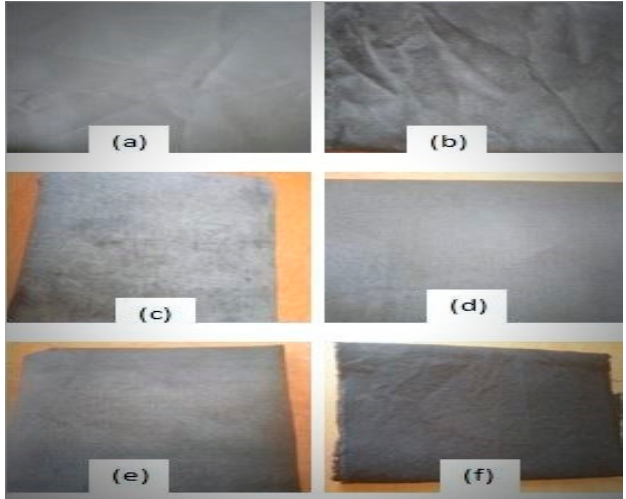
Figure 3. Controlled sample ( a ) and coated samples using coating mixtures of 7 mg/mL dispersant, 4 mg/mL ethanol, 6 mg/mL BTCA, 4 mg/ml of MgCl 2 , plus 4 mg/mL; ( b ) 6 mg/mL; ( c ) 7.5 mg/mL; ( d ) 9 mg/mL; ( e ) 10 mg/mL and ( f ) charcoal particles.